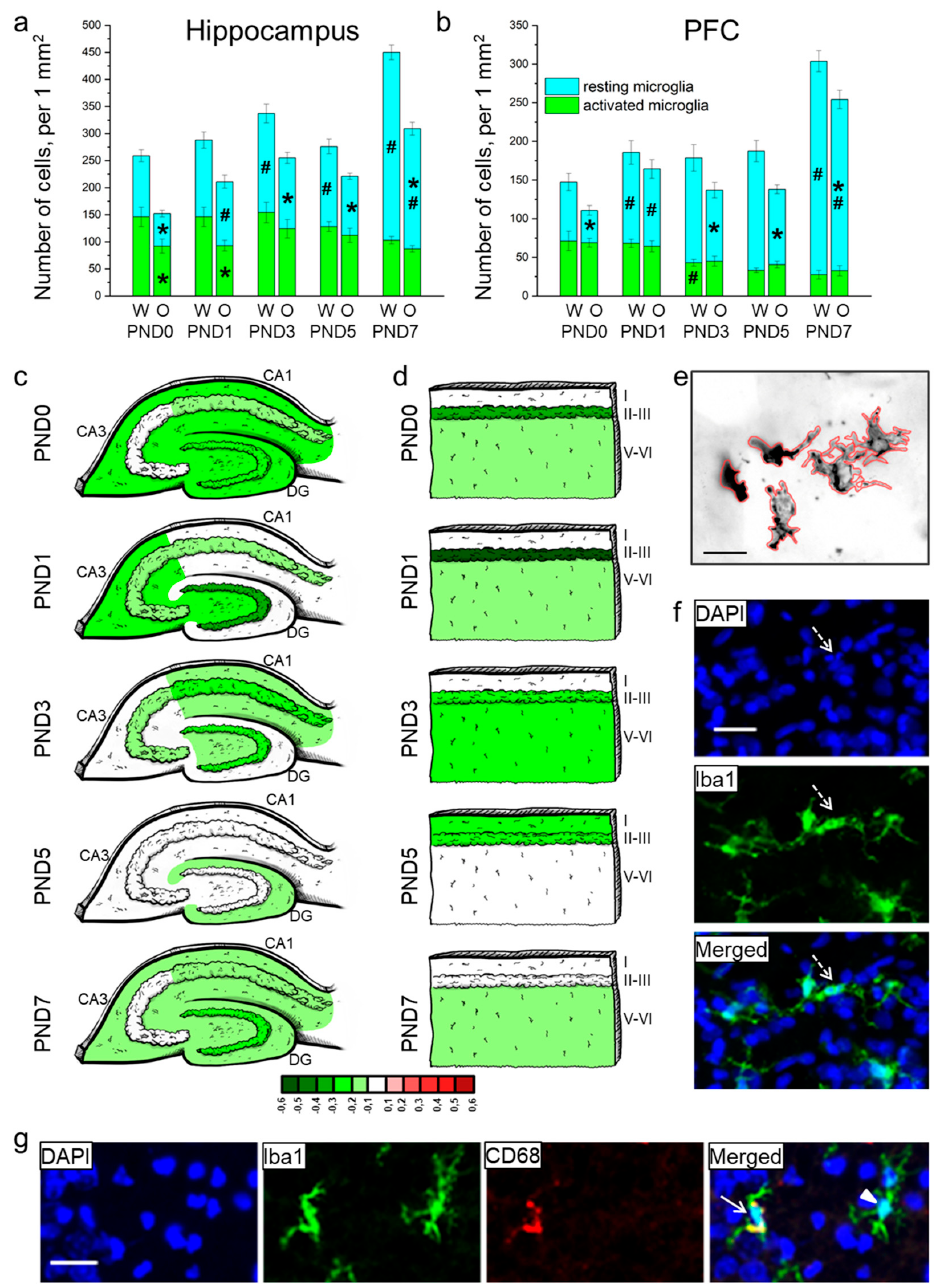
Figure 4. The density of microglia in the hippocampus ( a ) and PFC ( b ) of OXYS and Wistar rats during the first postnatal week. Changes in microglia density (meaning Iba1-positive cells) in regions of the hippocampus ( c ) and layers of the PFC ( d ) of OXYS rats compared to Wistar rats are presented schematically with Iba1 + cell density in each region and layer coded as a heatmap on a lg scale from − 0.6 to 0.6. ( e ) The area of microglial cells was measured using ImageJ software. ( f ) A pyknotic nucleus (pointed out by a dotted arrow) covered by microglial cytoplasm. ( g ) A representative image of Iba1 (green)- and CD68 (red)-positive cells in the hippocampus of a Wistar rat at PND7; the arrow points to an activated microglial cell, and the arrowhead indicates a resting microglial cell. DAPI (blue) stains cell nuclei ( f , g ); the scale bar is 20 μ m ( e – g ). W: Wistar; O: OXYS; I: cortical layer I; II-III: cortical layers II–III; and V-VI: cortical layers V–VI; solid arrow: an activated microglial cell; arrowhead: a resting microglial cell; dotted arrow: a pyknotic nucleus. The data ( a , b ) are presented as mean ± SEM; * p < 0.05 for differences between the strains; # p < 0.05 for differences from a previous time point.